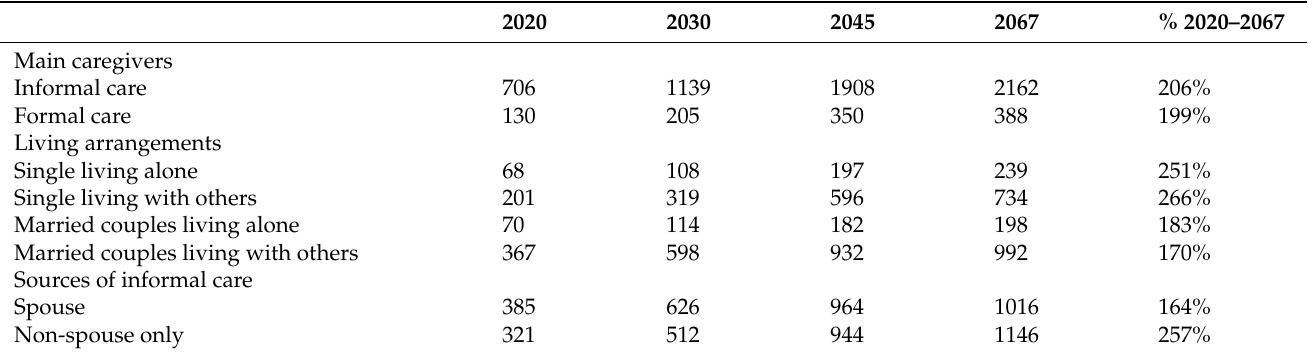
Table 4. Projected demand for community-based long-term care (unit: thousand people).